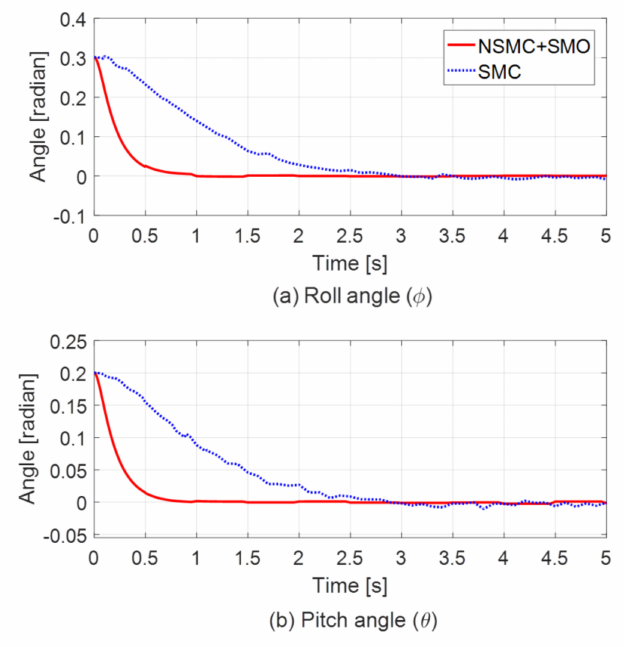
Figure 5. Stabilization of quadrotor with a slanted initial angle.